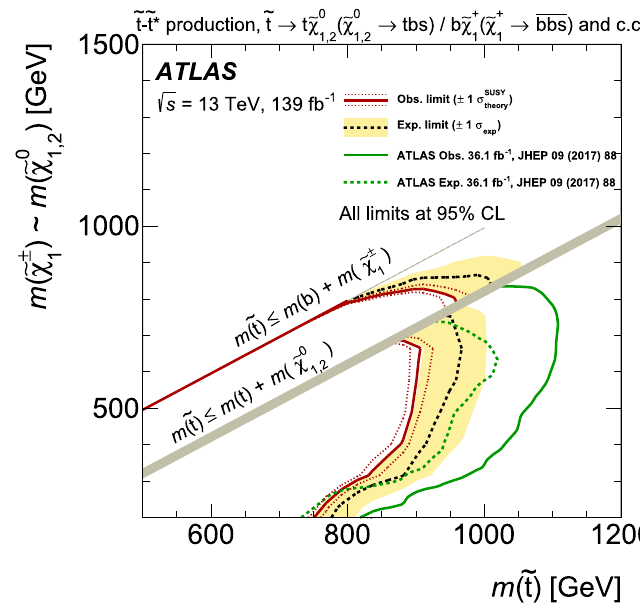
Fig. 8 Observed and expected exclusion contours for the ˜ t and χ ± masses in a top-squark production model with RPV decays of the χ ± and of the ˜ χ 0 . Limits are shown in the case of a higgsino LSP. The 1 , 2 contours of the band around the expected limit are the ± 1 σ variations, including all uncertainties except theoretical uncertainties in the sig- nal cross-section. The dotted lines around the observed limit illustrate